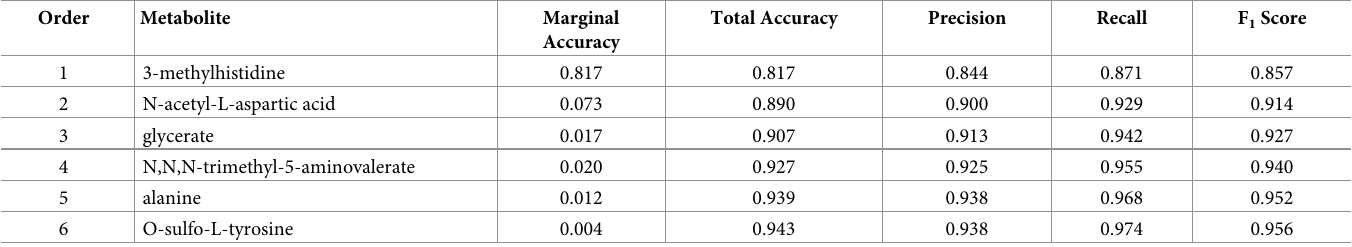
The marginal prediction accuracy associated with each metabolite in the model is reported in Table 3. The full confusion matrices reporting the number of true positives, true negatives, false positives, and false negatives for each iteration can be found in S5 Table. Only two of the metabolites in our final SVM, 3-methylhistidine and N-acetyl-L-aspartic acid, were identified as significantly associated with wooden breast in the previously described mixed linear model analysis. The relatively low overlap of results between these two analyses is likely due, at least in part, to correlation structure among metabolites, which is considered redundant information with regards to prediction accuracy of a classification model. We Table 3. Optimal metabolite set for wooden breast classification using support vector machine with stepwise feature selection and relevant performance measures. Accuracy is calculated as true positives / (true positives + false positives + true negatives + false negatives). Marginal prediction accuracy is the increase in total prediction accuracy achieved by adding the associated metabolite. Precision is calculated as true positives / (true positives + false positives). Recall is calculated as true positives / (true positives + false negatives).